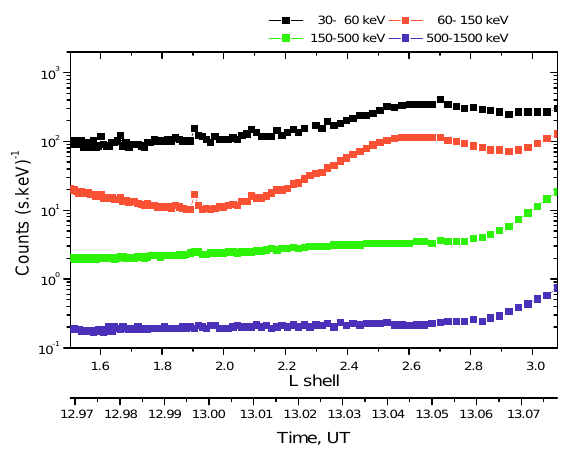
Fig.7. SameasFig.3foronepassageonday313(November9). Fig. 7. Same as Fig. 3 for one passage on day 313 (9